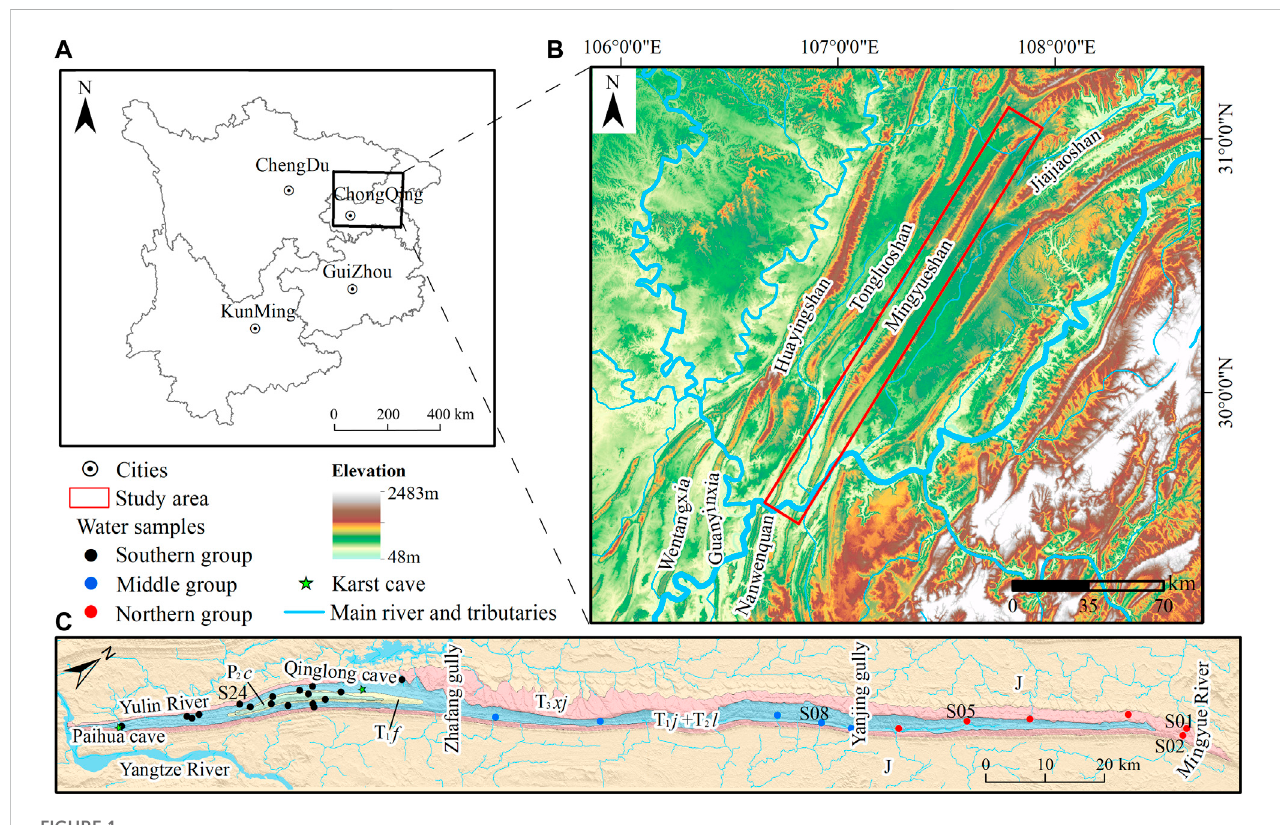
FIGURE 1 (A) Map of study area. (B) Altitude DEM rendering map of study area. (C) Overview map of the study area indicating water